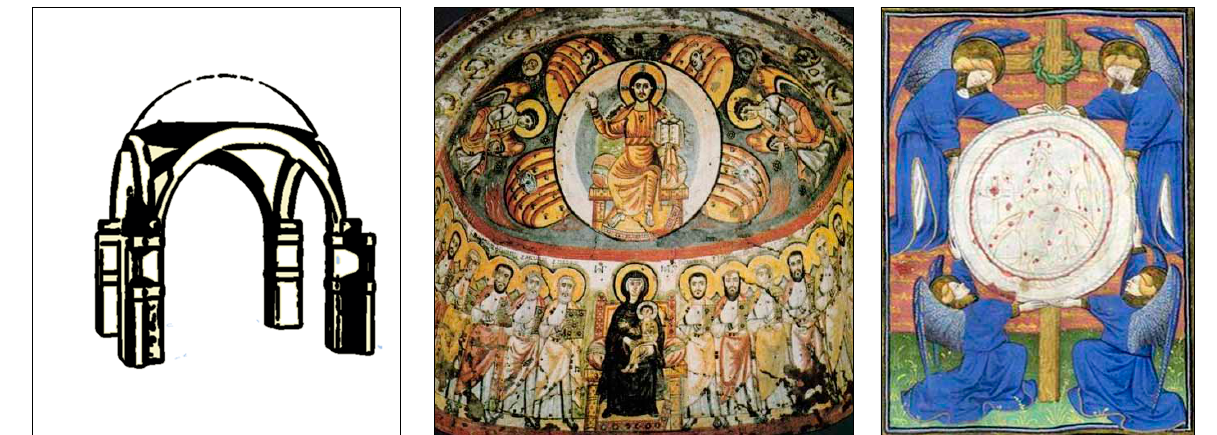
fig. 1. Main constructional scheme of Hagia Sophia built in the 6th century, in comparison with traditional Christian iconography of a tetramorph: the 4th century fresco at the Monastery of St. apollo in Egypt (middle) and the 15th century manuscript “Horae ad usum Parisiensem”. Sources : http://st-takla.org/Gallery/Saints-and-figures/Twelve-Disciples/12-apostles--12-